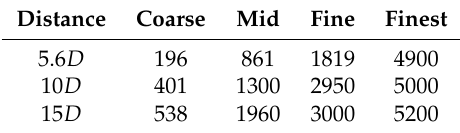
Table 3. Computational mesh sizes (number of cells in thousands) for different